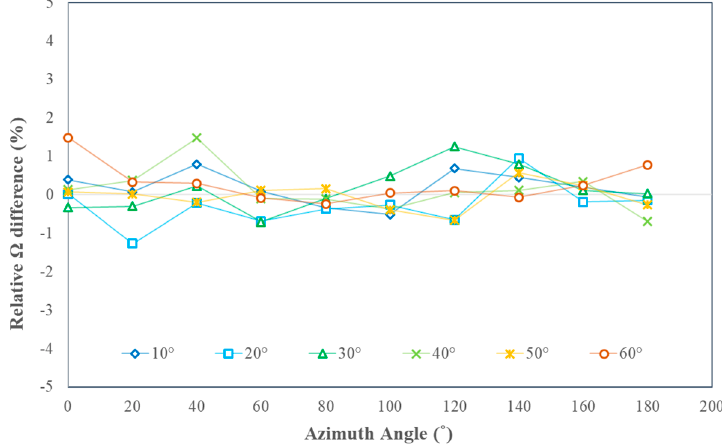
Figure 6. Relative discrepancy between simulated and modeled crop clumping index for different zenith angles at specific azimuth